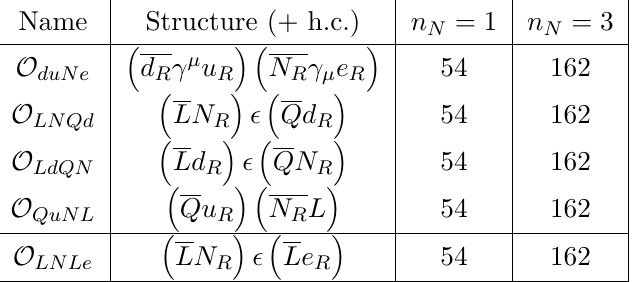
Table 1 . Lepton-number-conserving four-fermion single- N R operators. For each operator structure, we provide the number of independent real parameters for n N = 1 and n N = 3 generations of N R . The operator in the last row is purely leptonic, and thus, it does not contribute to the HNL production at the